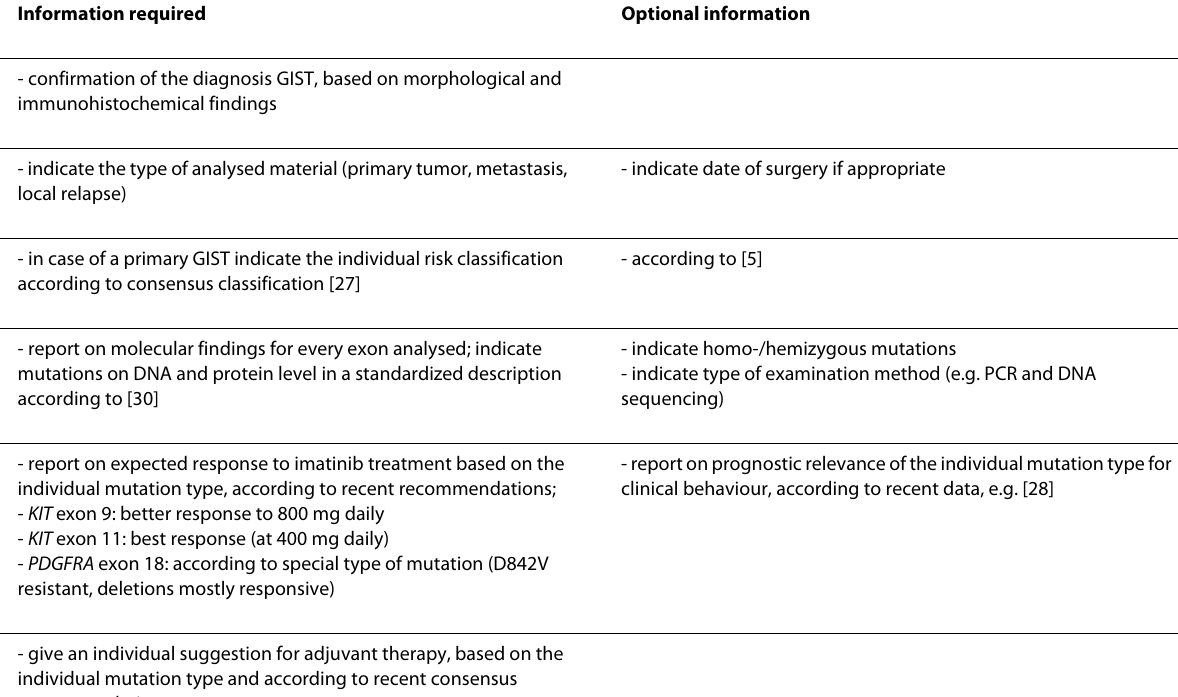
Table 4: Proposal for reporting of mutational results in GISTs Information required Optional